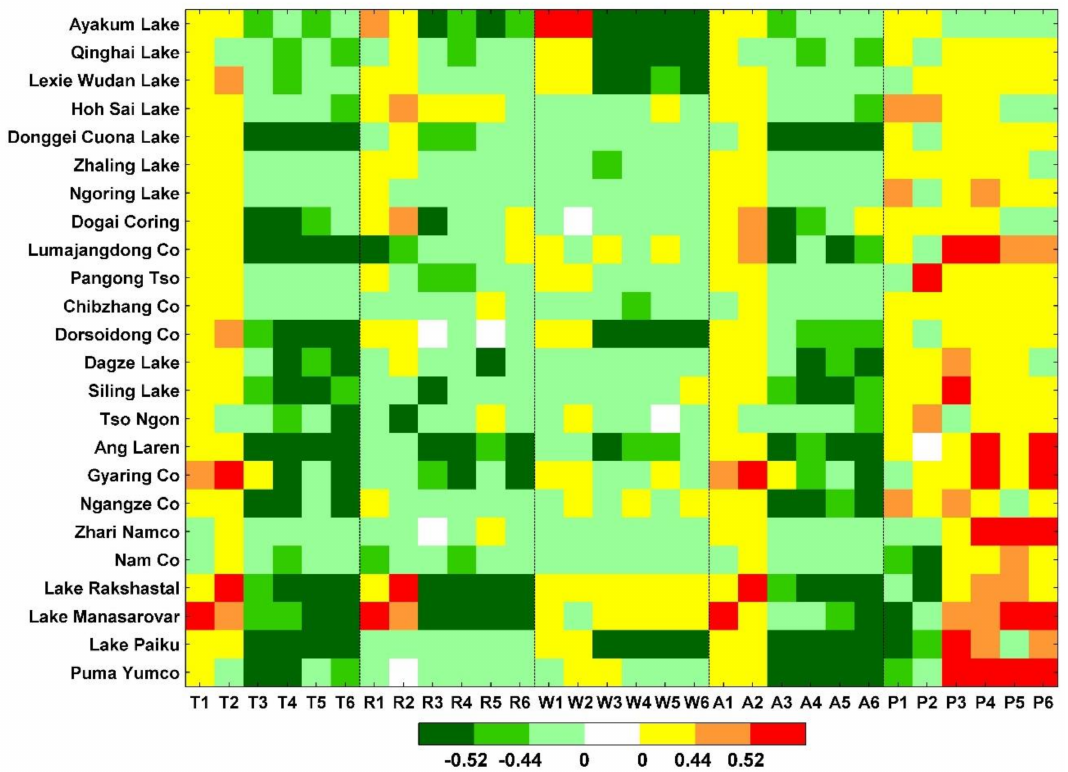
Figure 5. Heatmap of correlation coefficients between lake ice phenology indices and climate factors. T, R, W, A, and P represent temperature, radiation, wind speed, air pressure, and precipitation, respectively. The FUS, FUE, BUS, BUE, CID and ID are notated by 1–6, respectively. For example, T1 represents the correlation between temperature and